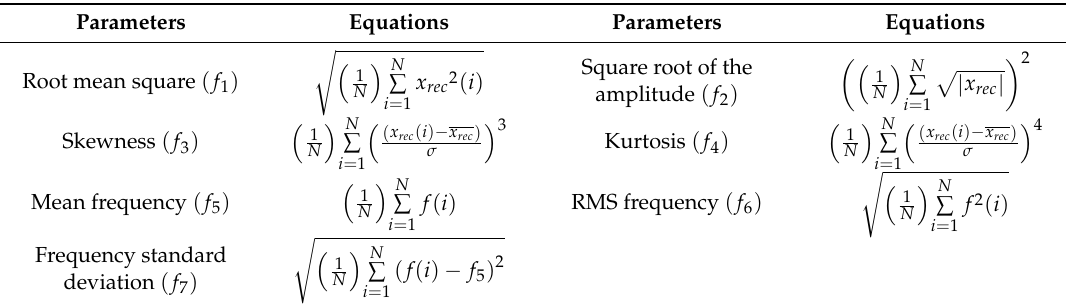
Table 2. Time- and frequency-domain statistical feature parameters. Where x rec is the reconstructed signal in the time domain, f is the spectral component of the reconstructed signal x rec , and σ is the standard deviation of the reconstructed signal x rec . RMS, root mean